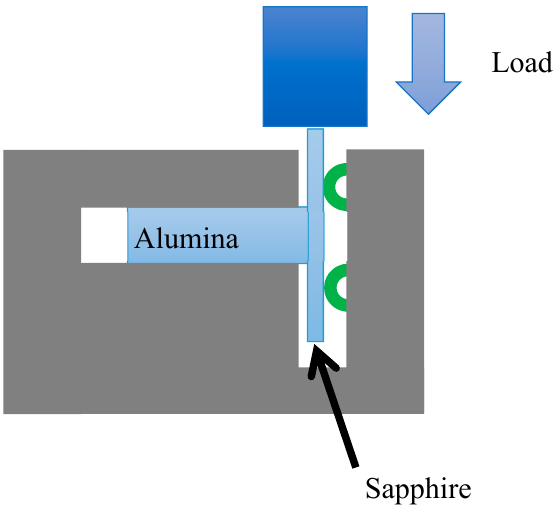
Figure 1. The schematic of the shear test for the joint, where the polycrystal alumina is fixed by the rig and a load is applied on the sapphire by the universal mechanical testing machine to generate a shear stress at the interface.